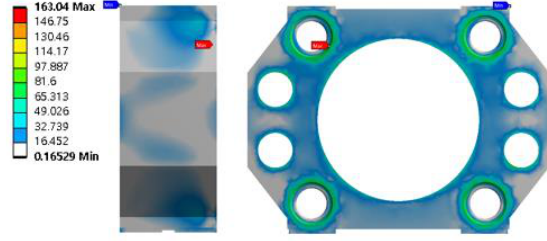
Figure 7. Von-mises stress of main cylinder housing.